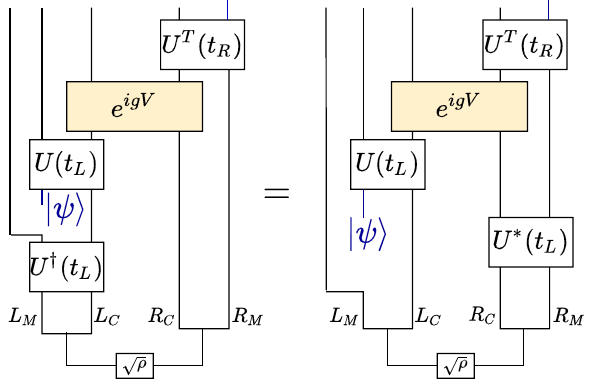
Fig. 8 Many-body generalization of the teleportation through worm- hole: Both the left and right systems are divided into message (labeled by a subscript M ) and carrier (labeled by subscript C ) subsystems. Inspired from the gravity description, the left of an initially prepared TFD at t = 0 is evolved backward with U † to reach − t . At − t an information, shown with a state | ψ (cid:7) , is inserted. Then after forward evolution of left, a momentary coupling is introduced between the car- riersubsystemsontwosides.Therightsideisforwardevolvedwith U T , after which the teleported state can be read (see main text). The left and right circuits are exactly the same for evolution unitary described by the underlying one sided Hamiltonian U = exp ( − iHt ) , on accounts of the identity